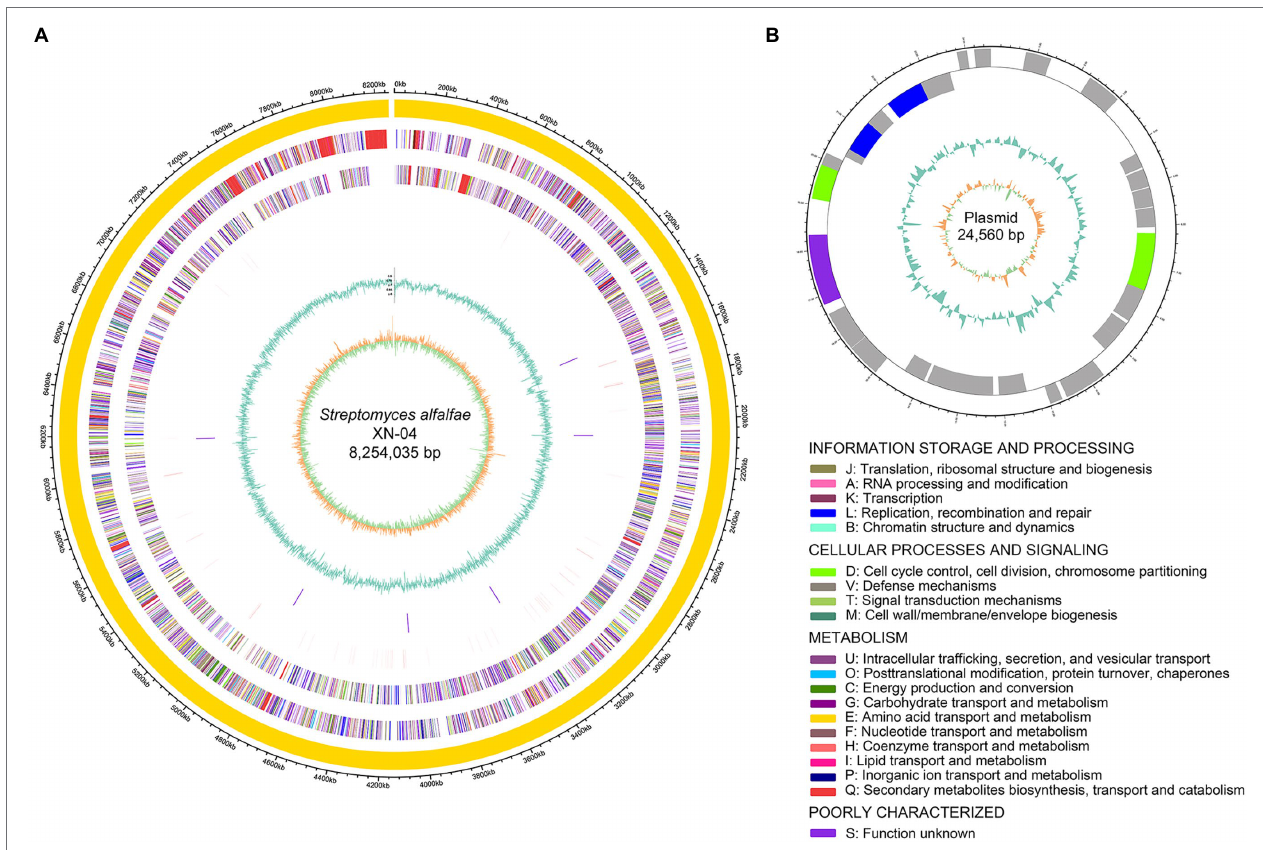
FIGURE 4 | Genome map of XN-04. (A) Genetic map of the circular chromosome; (B) genetic map of the circular plasmid. The circular map consists of six circles, from the outside circle to the inward. Circle 1 shows the distribution of genes related to COG categories in the forward strand; circle 2 shows CDS region including tRNA, rRNA, and others in forward strand; circle 3 shows CDS region including tRNA, rRNA, and others in the backward strand; circle 4 shows the distribution of genes related to COG categories in the backward strand; circle 5 shows the GC content; and circle 6 shows the GC skew.